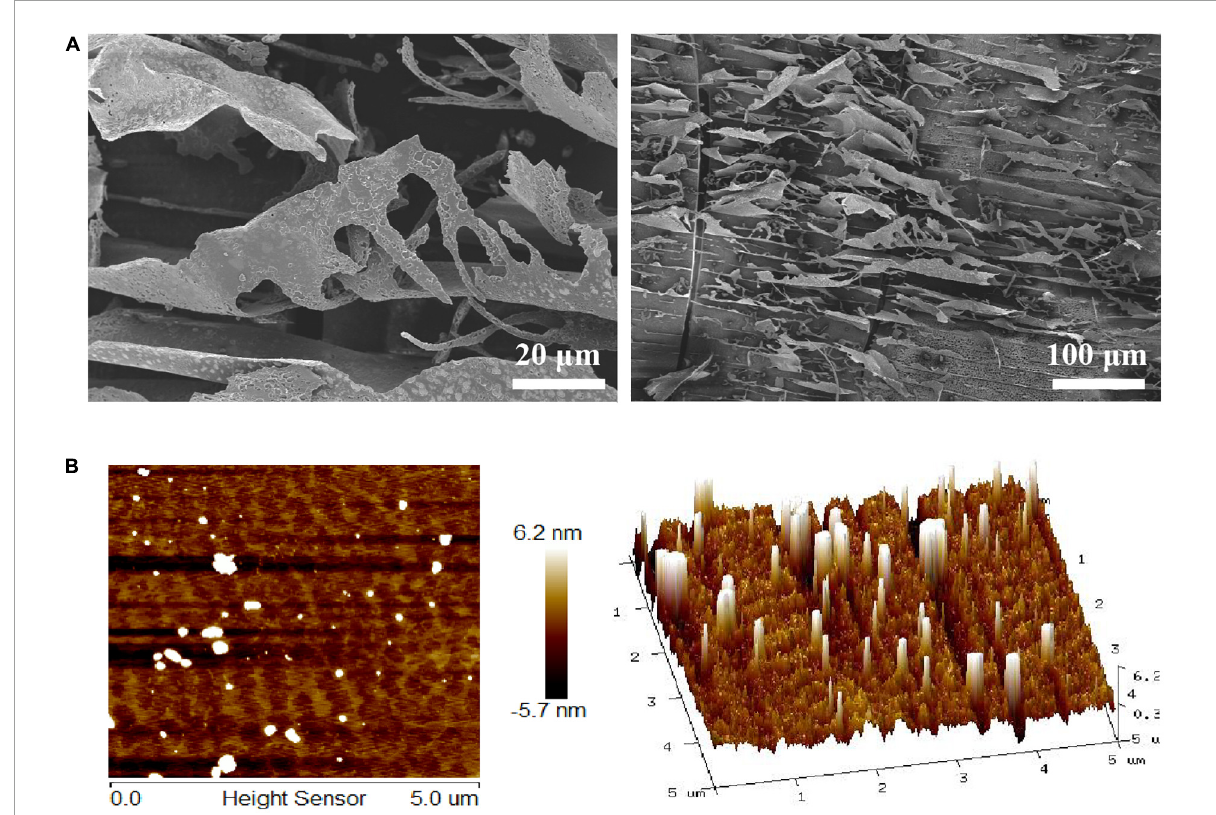
FIGURE2 Surface morphology of LFP-80-W1. (A) SEM image (500 × and 100 × magnification); (B) AFM image and 3D